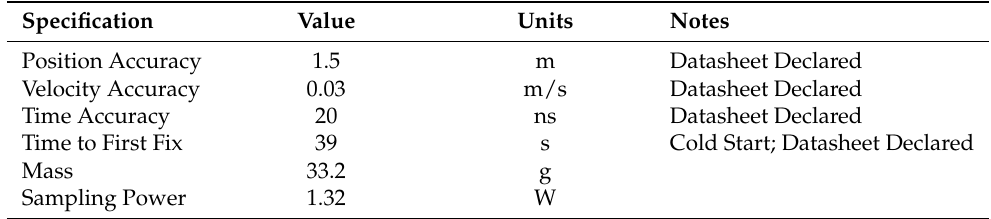
Table 7. Novatel OEM719 GNSS receiver specifications.